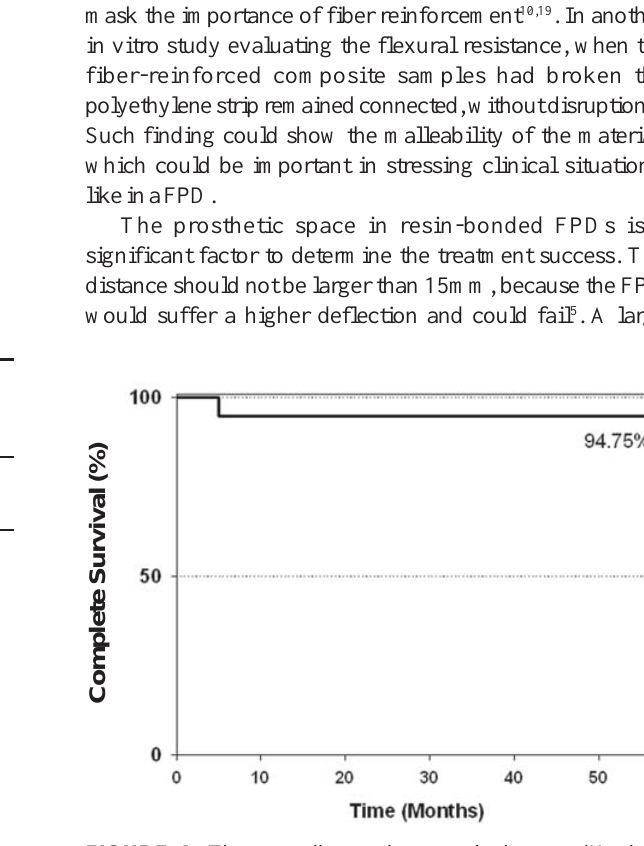
FIGURE 1- The overall complete survival curve (Kaplan- Meier) of the FPD illustrated a 94.75% survival